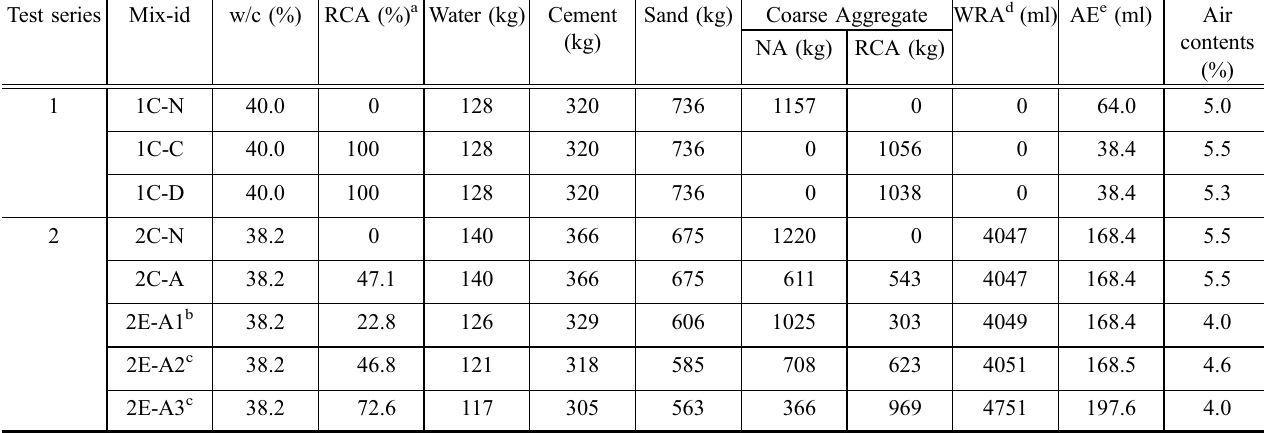
Table 3 Concrete mixture designs and material